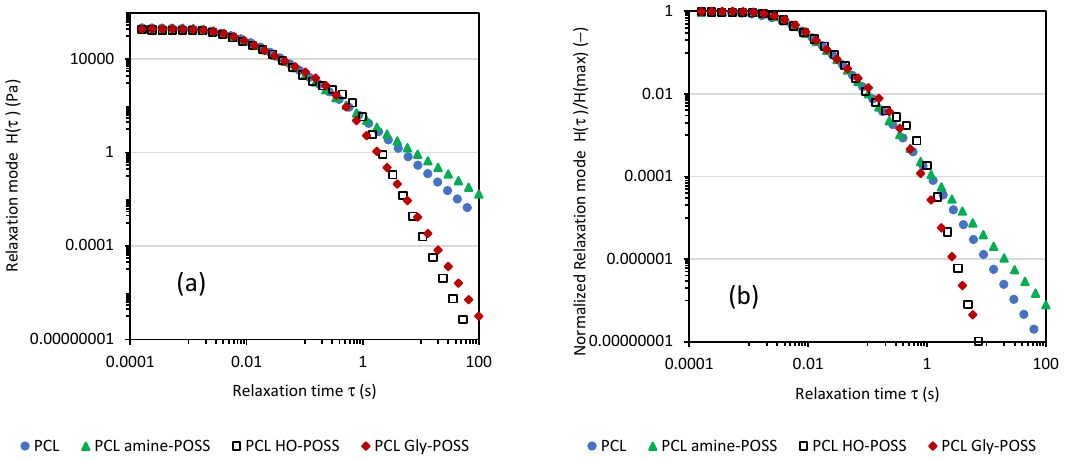
Figure 5. Continuous relaxation spectra for PCL samples modified by POSS ( a ). Normalized relax- ation spectra for PCL samples modified by POSS ( b ).